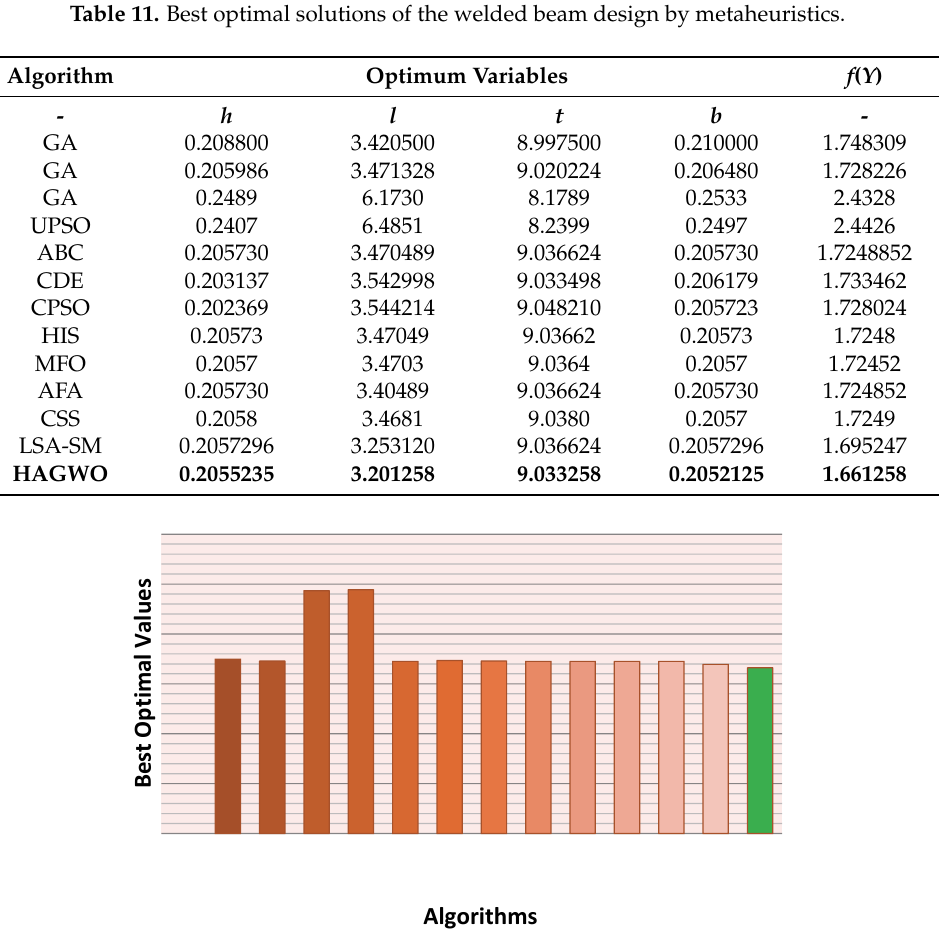
Figure 6. Comparison of best optimal value of the metaheuristics on welded beam design problem.